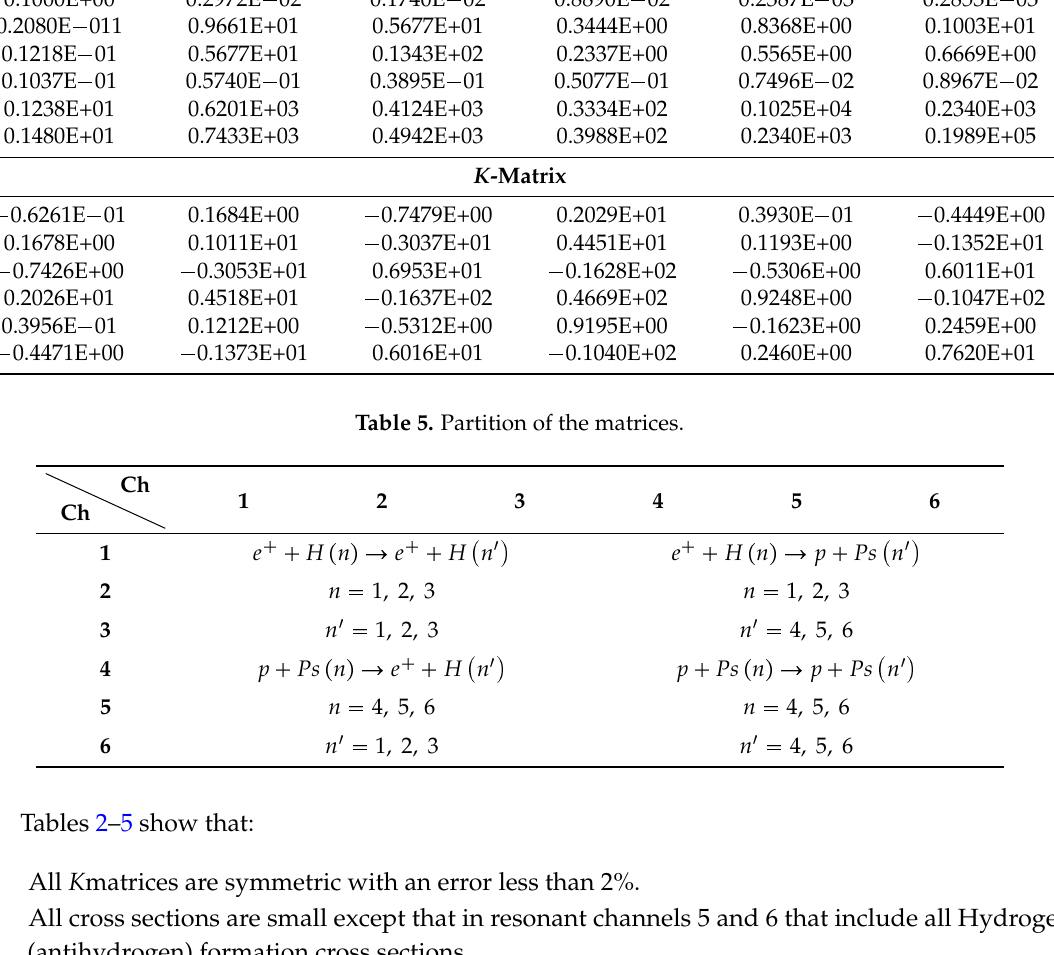
Table 4. Properties of the third resonance. E 3 = 0.87454; ε 3 = 0.84344 (cid:2) 10 (cid:1) 4 Cross Section Matrix